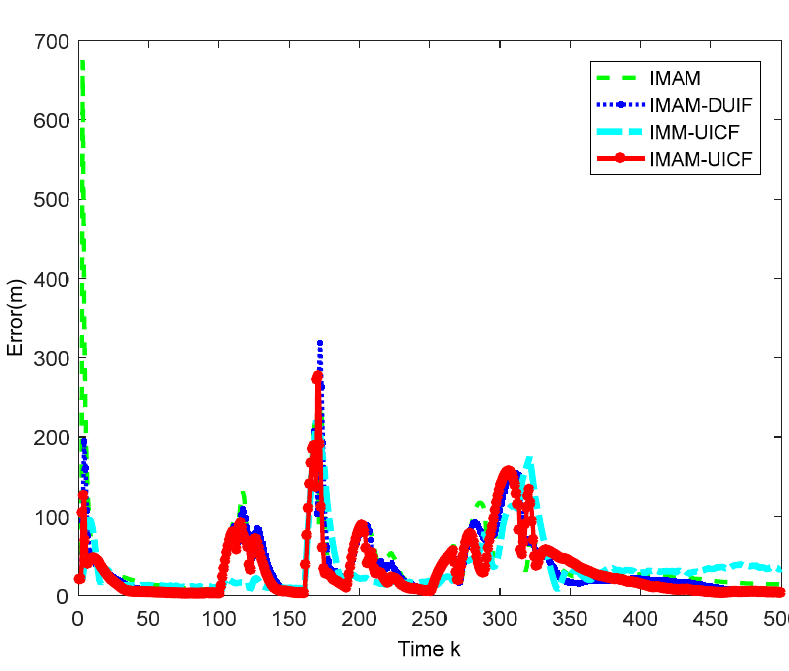
Figure 9. Velocity RMSE of different sensors.